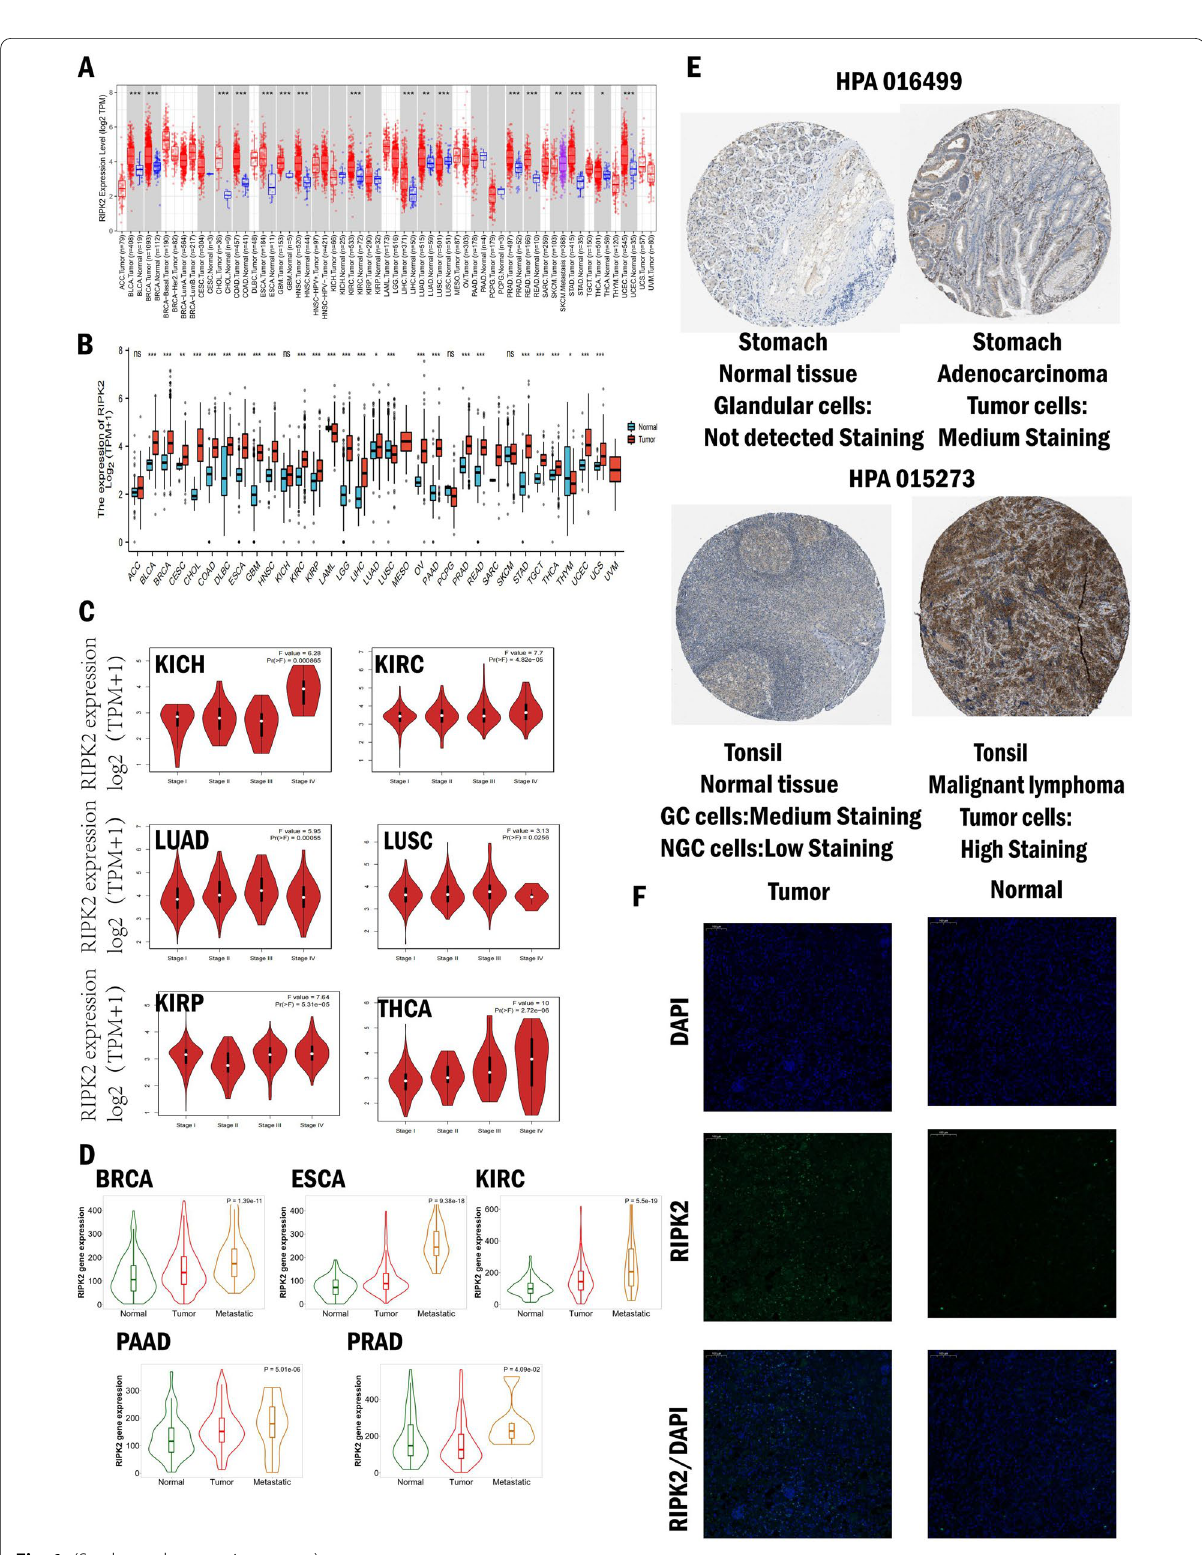
Fig. 1 (See legend on previous